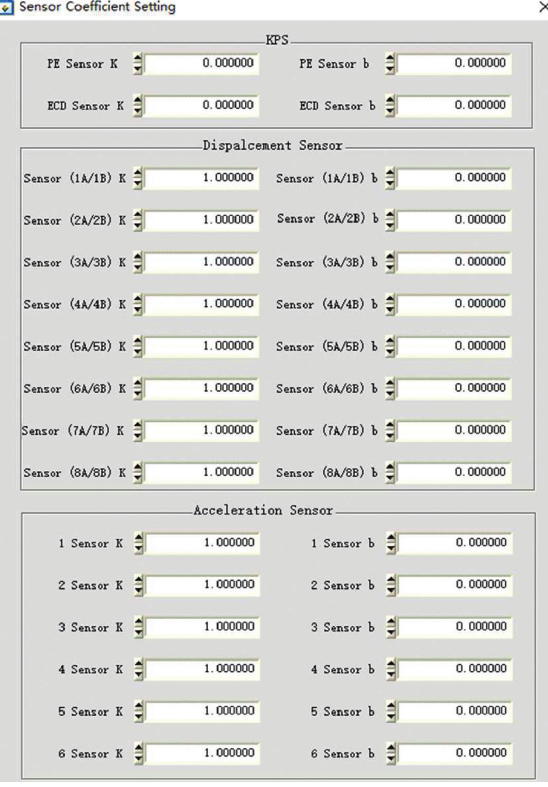
Figure 8: The sensor coefficient setting interface.